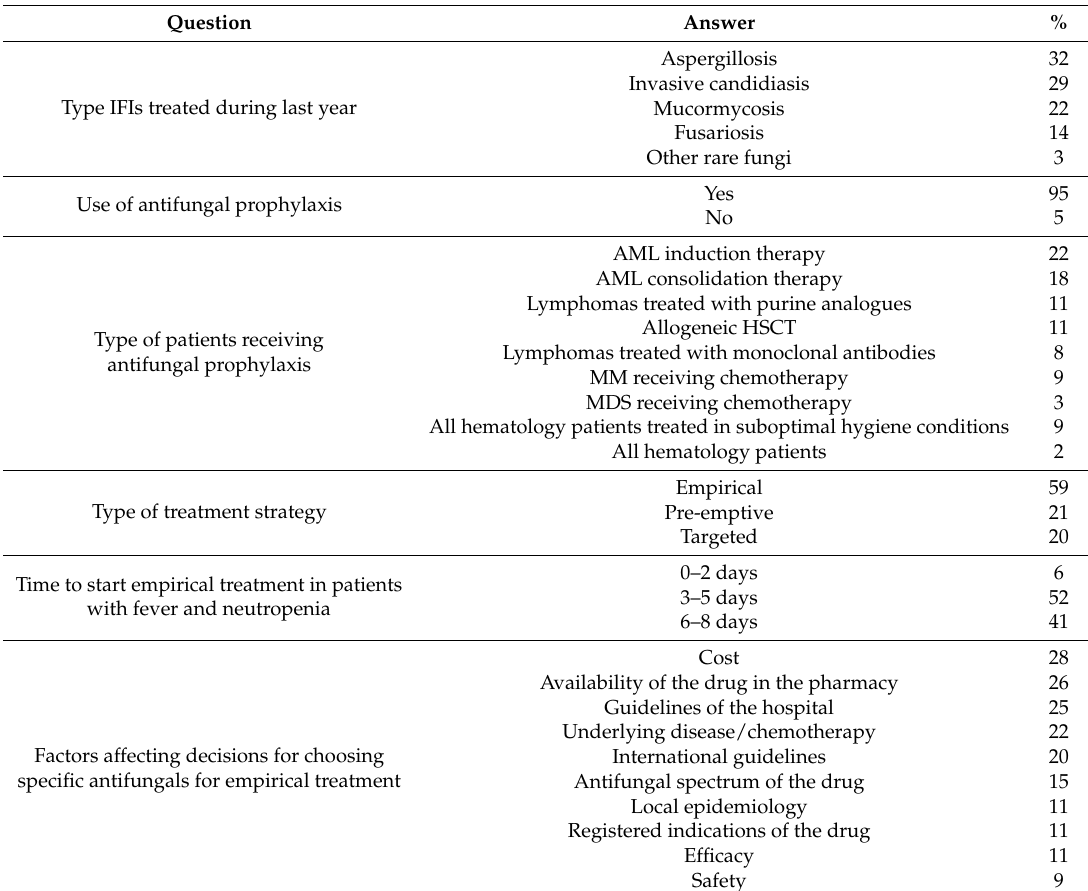
Table 4. Treatment strategies for documented or presumed